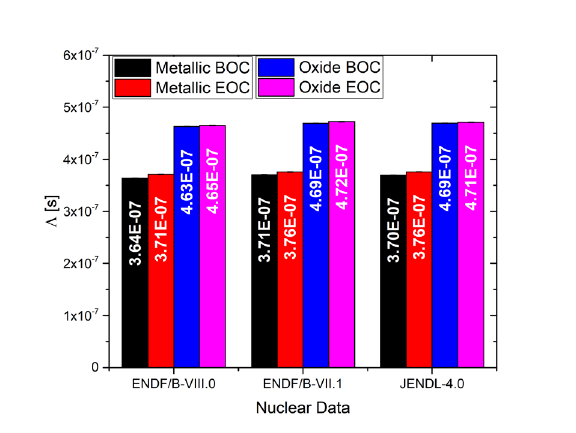
Table 3. Impact of the specific isotope library from Figure 2. Radial Layout of Oxide Core [1]